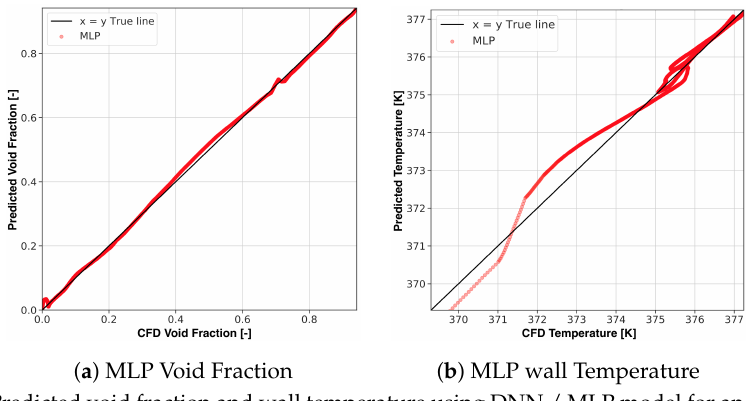
Figure A1. Predicted void fraction and wall temperature using DNN / MLP model for an interpolation dataset at q (cid:48)(cid:48) = 14,000 W/m 2 , u = 0.05 ms − 1 , from the plot it can be noted it has high nonlinearity while predicting the wall temperature.